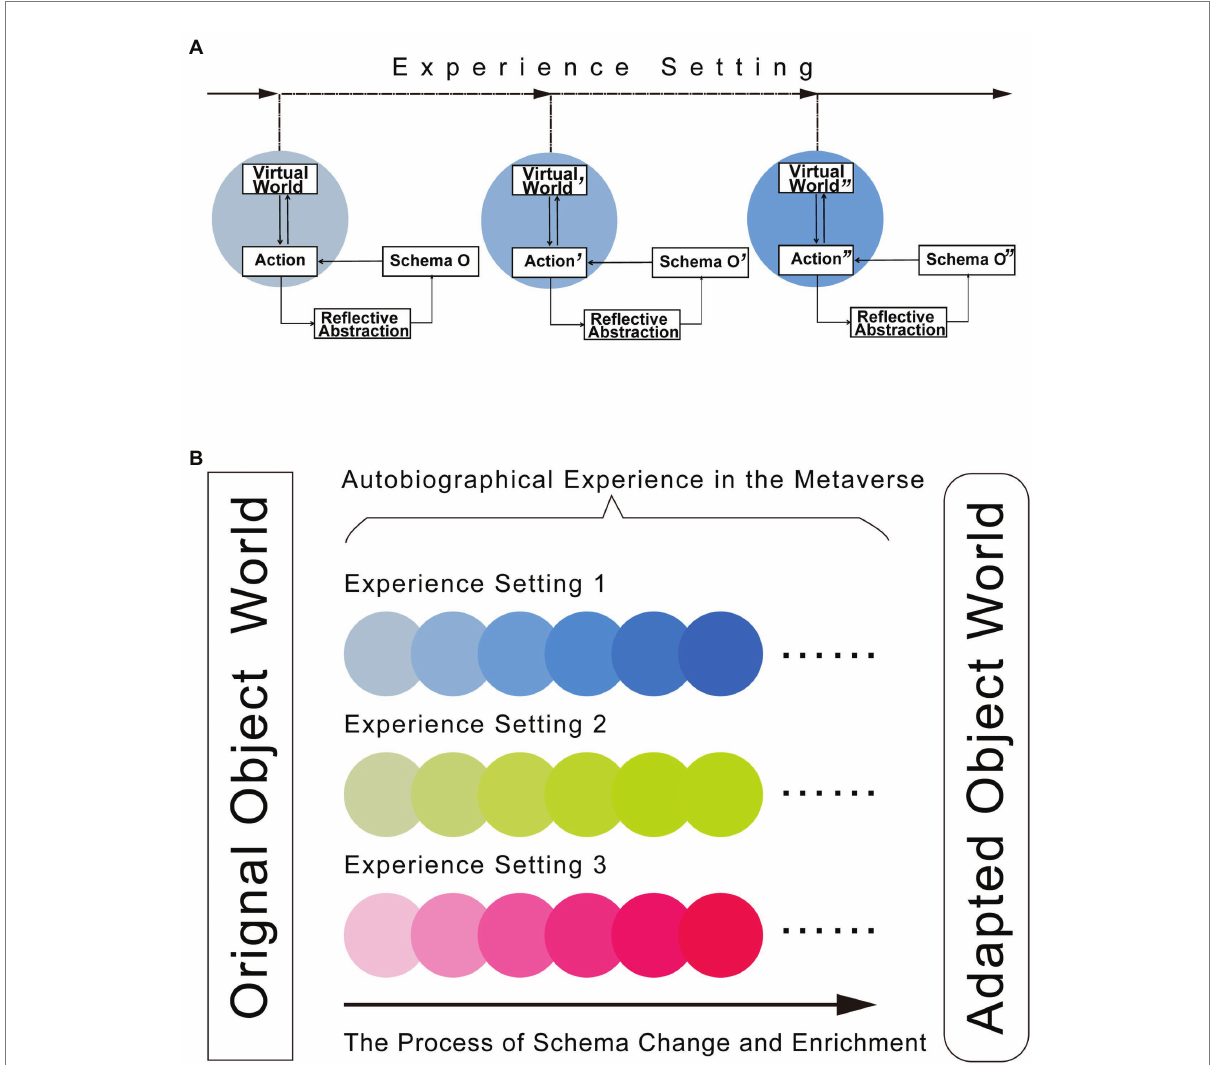
FIGURE 2 Mechanism and process of how the metaverse can be used as a tool for reshaping schema modes. (A) The mechanism of schema mode changes in the metaverse. After entering the metaverse, the client will encounter a virtual world with certain experience setting prescribed by the psychotherapist. The feedback of the interaction with the virtual world will be significantly different from the original world the subject is living in and where the original schema modes (O) are formed, and thus this difference in feedbacks will gradually bring about changes and enrichment in the schema modes toward a more adapted one (O ′ ) via reflective abstraction. The solid arrows at the top represent entering into the metaverse and returning to the real world. The dashed arrows represent entering into the multiple stages of the virtual world with certain experience setting, which is designed to foster gradual schema mode and behavioral changes through recursive interaction and reflective abstraction. The interaction between the action of the subject and the virtual world is represented by a double arrow. The background circles with different color gradients represent the convergent changes of the virtual world as defined by the experience setting and the subject’s behavior. (B) Flow chart of the metaverse as a tool for reshaping schema modes and its impact on the client living in the real world. The box on the left side of the diagram represents the original object world, in which the client’s behavior pattern may be fixed and the perception of the object world is based on predetermined schema modes. Each colored circle represents the occurrence of schema mode change brought about by the interaction between the virtual world and the client’s behavior, and a series of gradual changes in the colored circles represent the gradual change and enrichment of schema modes. Through different experience settings prescribed by the psychotherapist, the subject entering the metaverse can obtain a series of autobiographical experiences that will result in a more adaptive schema mode to behave in the real object world, and the enriched schema modes can also facilitate the activation of more adapted behaviors. The various interactions between the subject and the object world will also help people shape a more inclusive and accepting environment for the client and people alike. The box on the right side of the diagram represents the adapted object world the subject is able to live in with a high degree of mental health. The arrow from left to right at the bottom represents the process of schema mode change in the subject experience the